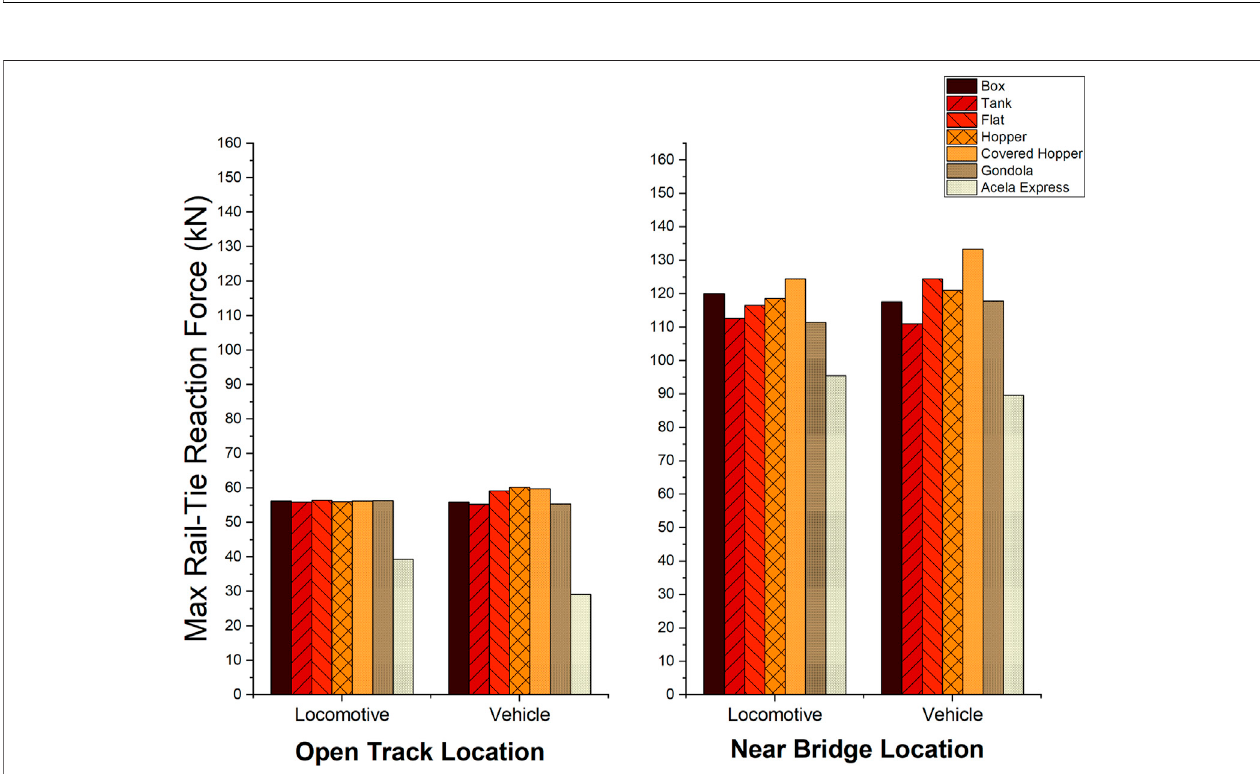
FIGURE 10 | Comparison of maximum rail-tie reaction forces with freight trains and passenger trains passage on shared track rail corridor.